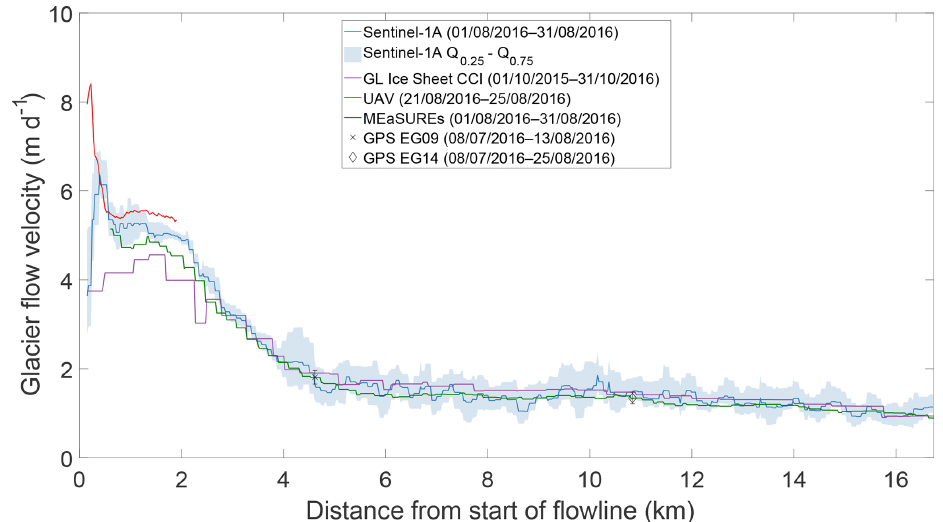
Figure A3. Mean flow speed along the central flowline (see Fig. 1) derived from S1A scenes acquired between 1 and 31 August 2016 (1 month), starting at the glacier’s terminus. The reference flow speed based on the 4d UAV mosaics acquired on 21 and 25 August 2016 is shown in red, and flow velocities from MEaSUREs and Greenland Ice Sheet CCI products are shown in green and purple.